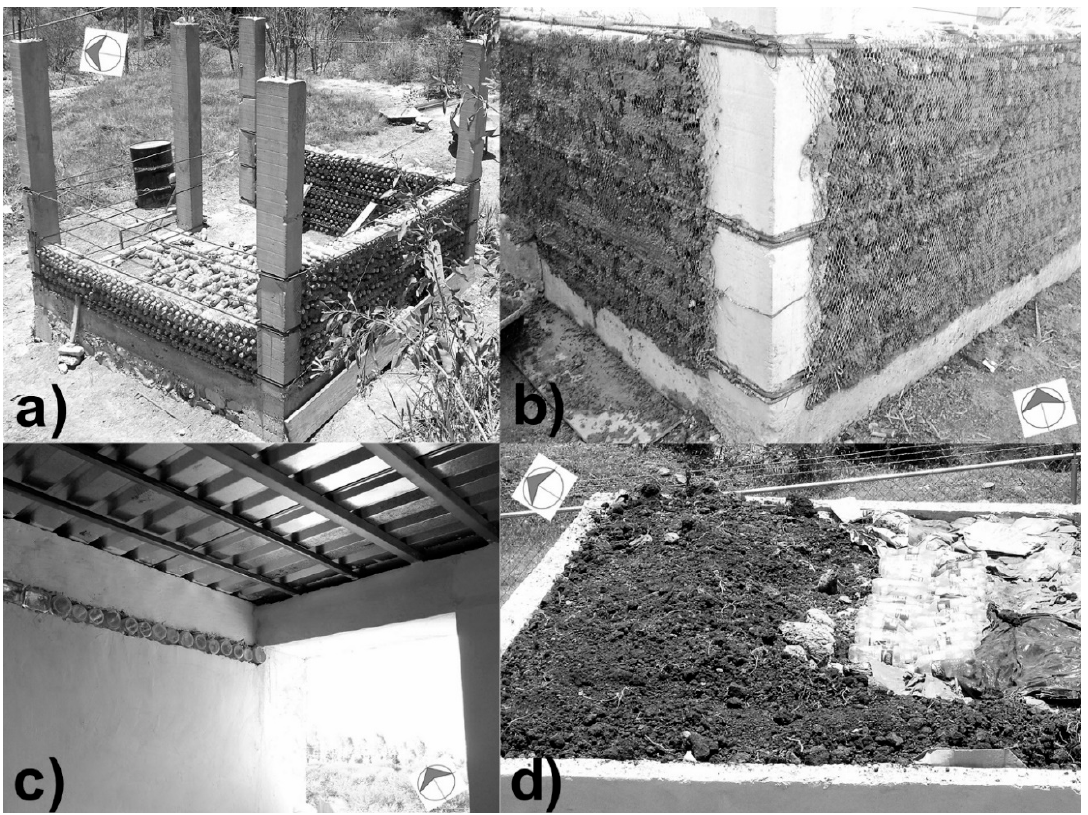
Figure 1. ( a ) Initial construction stages of a polyethylene terephthalate (PET) bottles prototype room, ( b ) stacking of PET bottles forming the wall base that was reinforced with steel rebars that were spaced one-half meter apart. ( c ) Internal view and ( d ) insulating multiple layers of the roof.